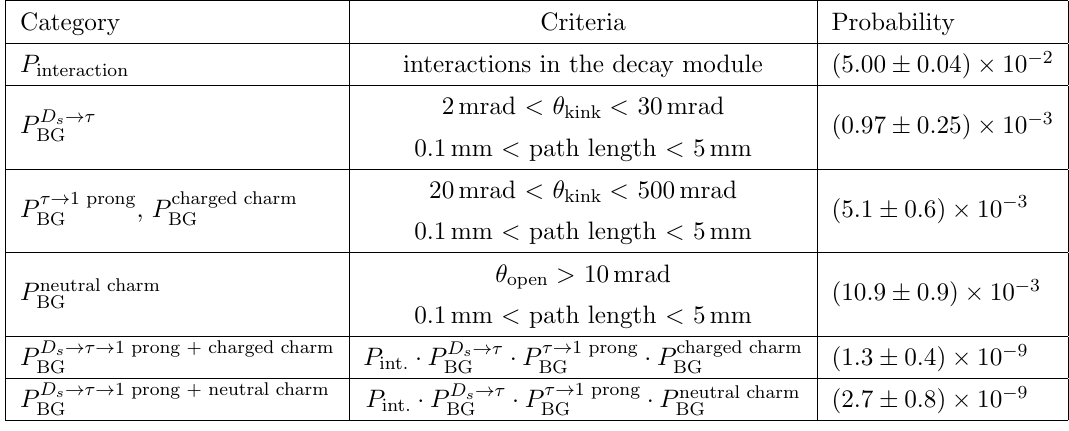
Table 2 . Probability of hadron interactions mimicking the speci(cid:12)c decay topology. are the probabilities per proton interactions. The rest are those per incident proton. The errors are due to the statistics of the MC data